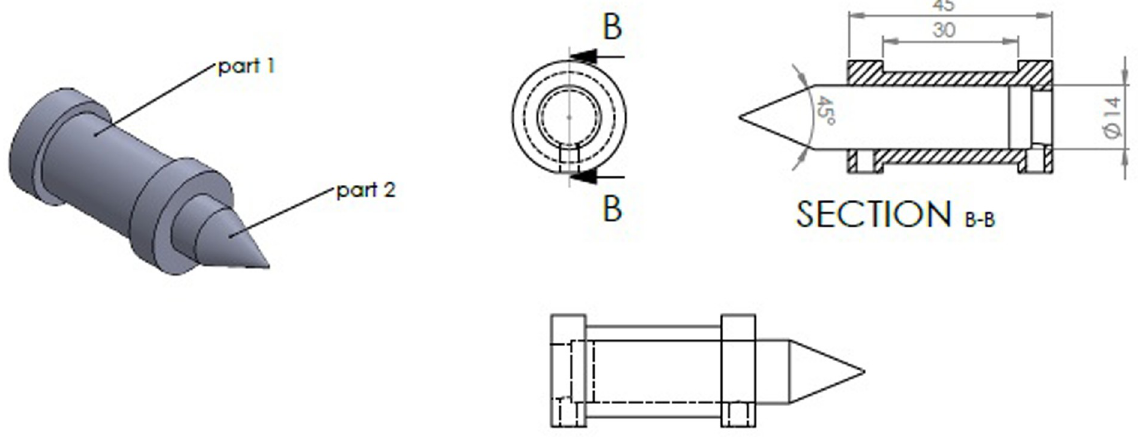
Fig 1. The 3D schematic of the designed electromagnet by SOLIDWORKS software; part 1: Cylindrical coil, part 2: Magnetic field focusing core tip (pole piece).